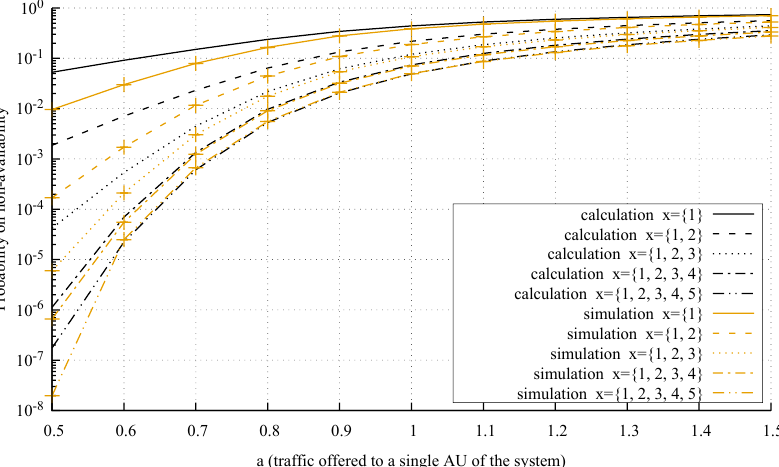
Figure 7. Probability of the non-availability of x strictly determined resources for class 1 calls ( t 1 = 1) in System 3, where x is the set of strictly determined resources in the limited-availability group.